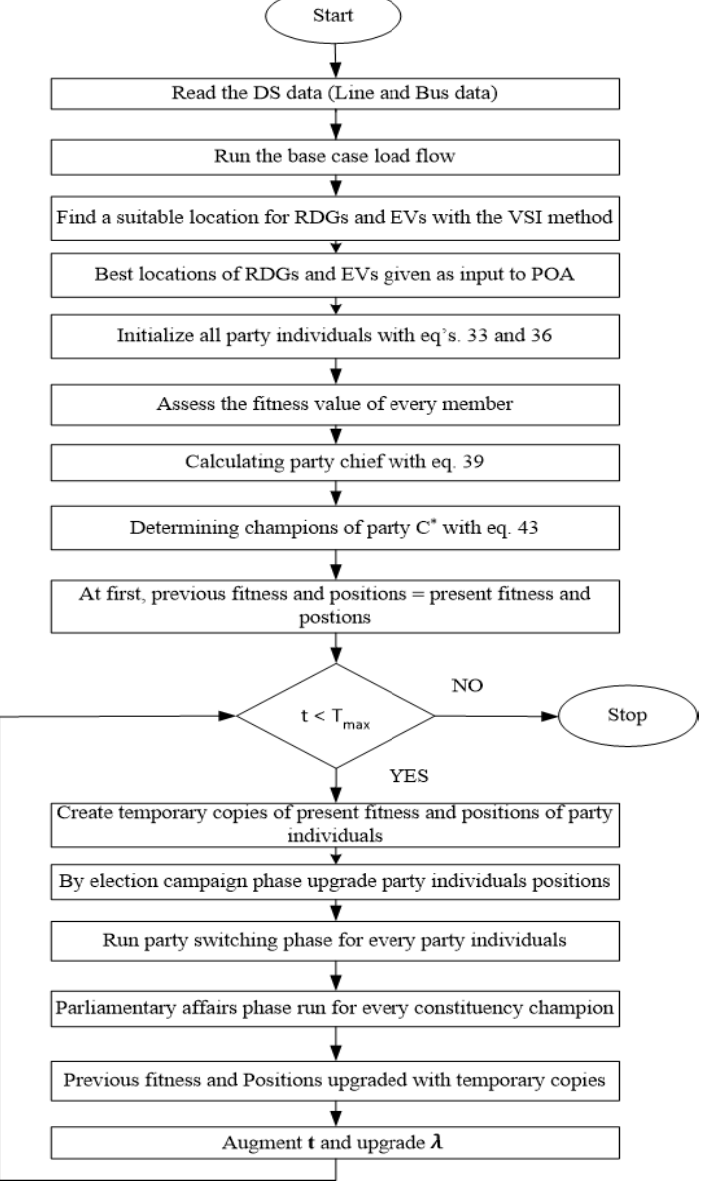
Figure 7. Flow Chart of POA.